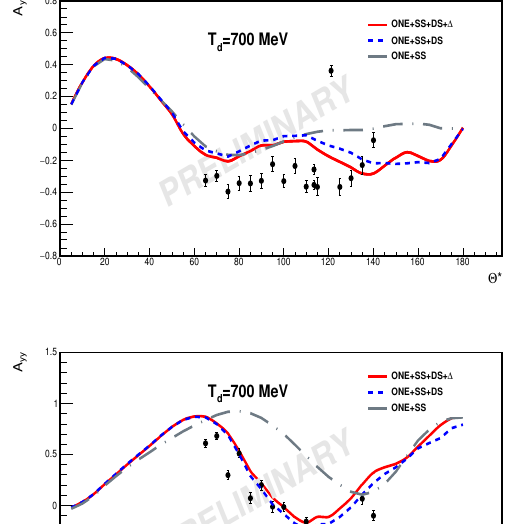
Figure 7. The angular dependence of the tensor analyzing power A yy at the deuteron kinetic energy T d of 700 MeV. Lines and symbols are the same as in Fig. 6